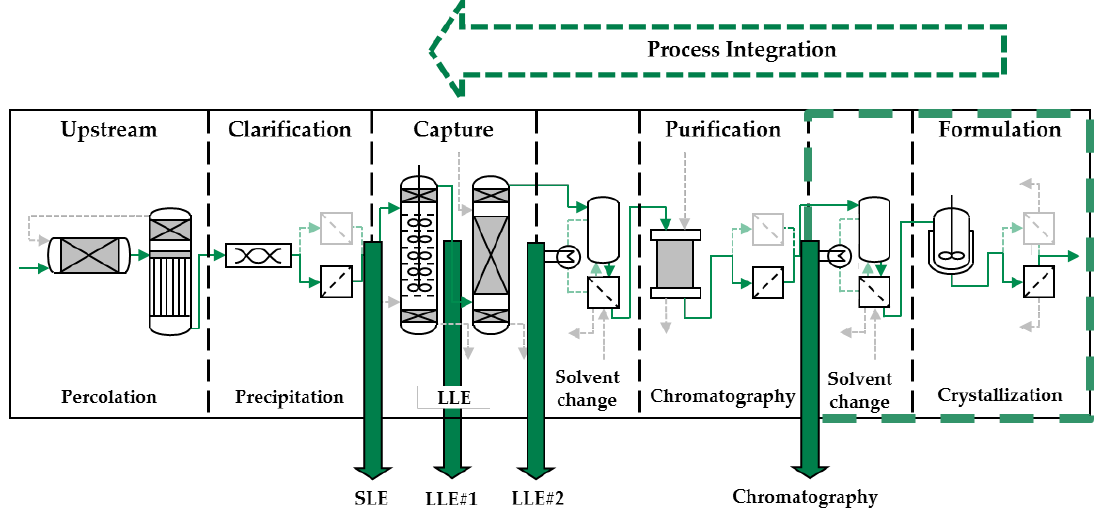
Figure 11. Possible process points for crystallization step. (SLE: Solid-liquid extraction)